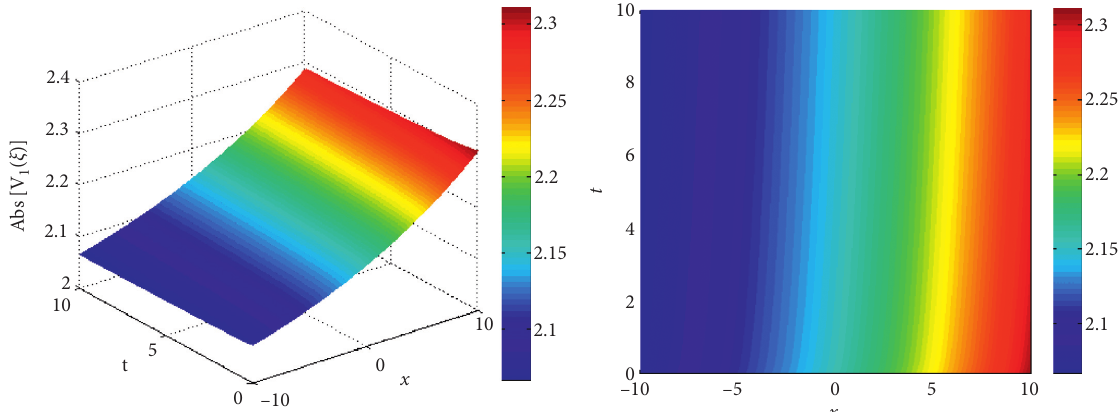
Figure 3: Soliton solutions of equation (34) in 3D and contour plots, where y � 2; v � 0 . 2; a � 3; u � 0.2; k 1 � 3; k 2 � 4; k � 0.02; λ � 4; and α � 0 .